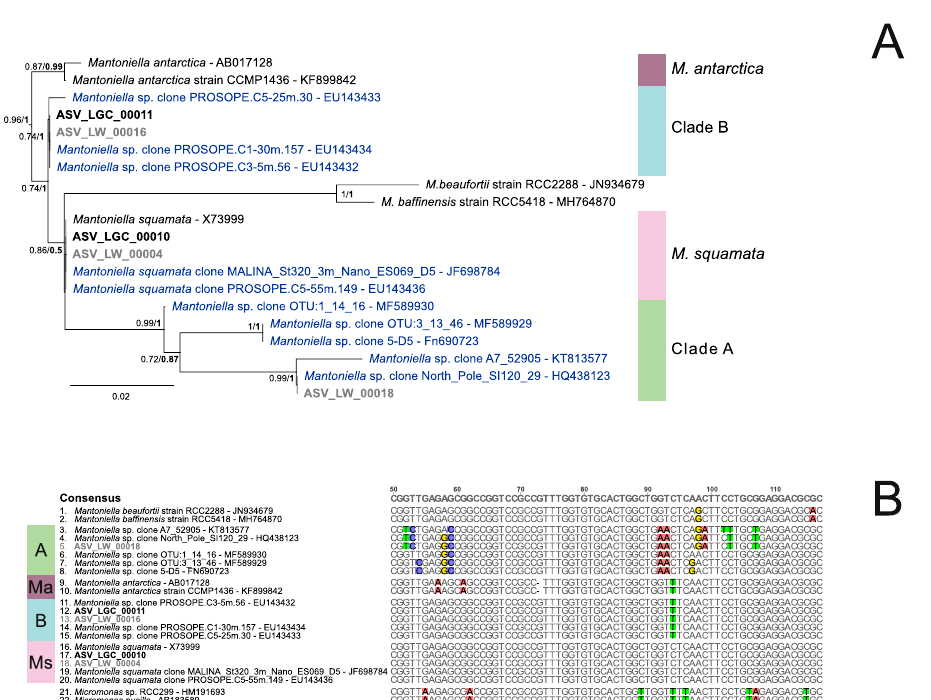
Figure 7. Phylogenetic diversity within the genus Mantoniella . ( A ) Phylogenetic tree of 19 Mantoniella sequences from the V4 region of the 18S rRNA gene (FastTree). The tree was rooted with the 3 Micromonas sequences (AB183589, HM191693, and JF698749). Legend as in Fig. 2. ( B ) Alignment of 19 Mantoniella V4 regions, the alignment was 368 bp long, but only the main signatures are shown (between the 20th and 141st position of the original